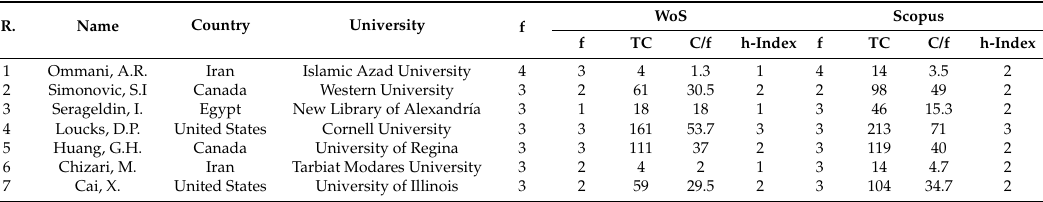
Table 5. Ranking of the most productive authors.